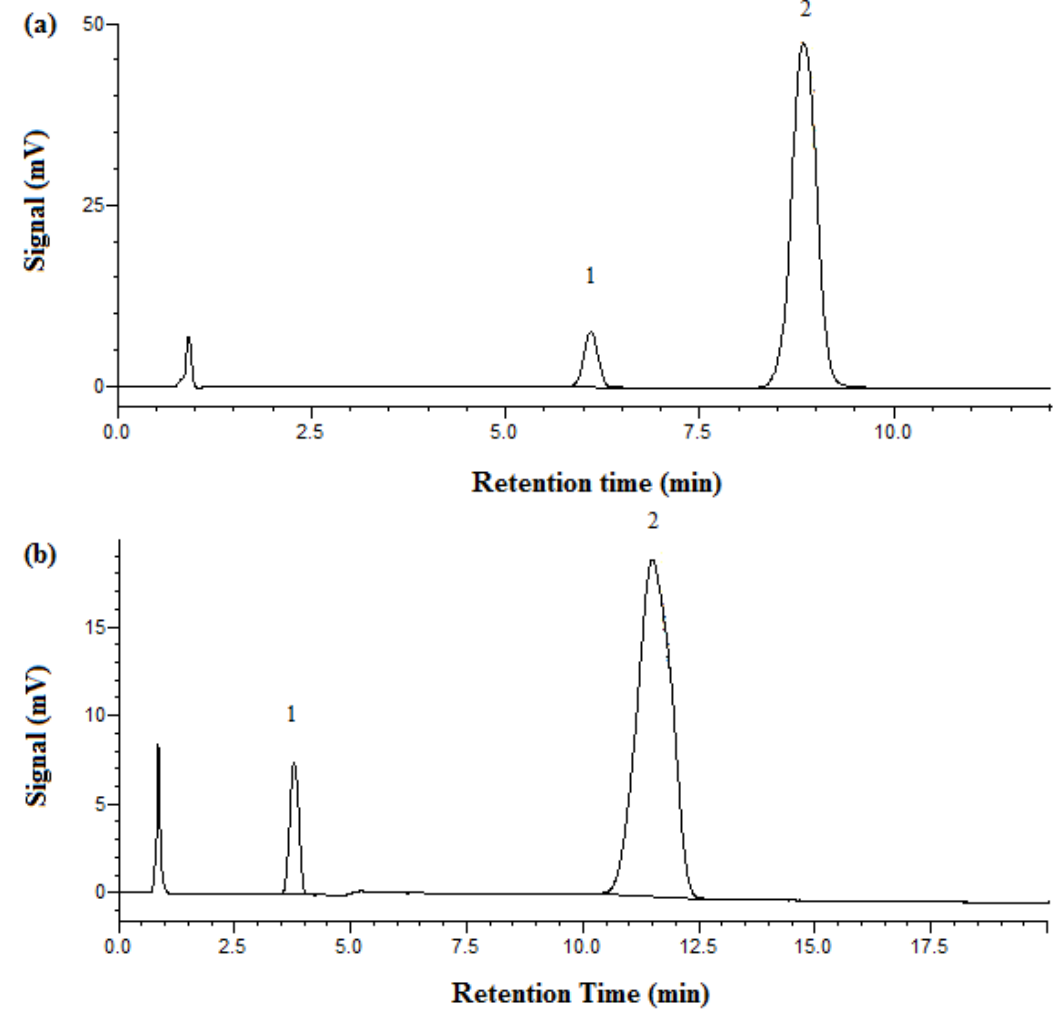
Figure 2. Chromatograms of aspirin obtained on the XBridge C18 column with 1.5 mL/min and UV detection at 254 nm. ( a ) HPLC at 25 °C, mobile phase: 85% phosphate buffer at pH 3.4 and 15% acetonitrile. ( b ) SBWC at 125 °C, mobile phase: 100% phosphate buffer at pH 3.4. Peak identification: 1. phenol, 2. aspirin.